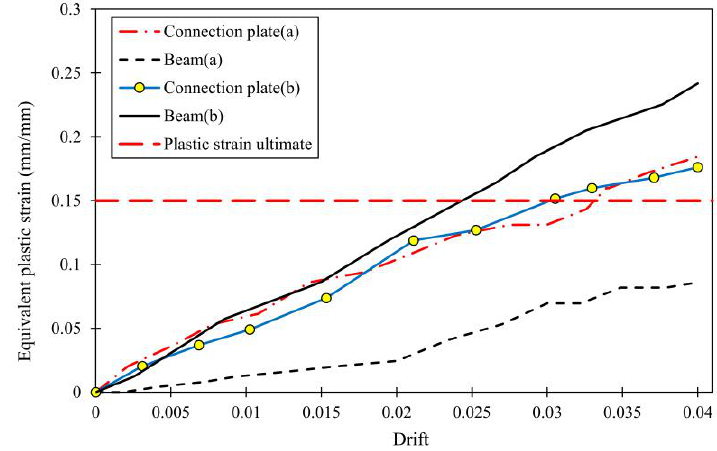
Figure 15. Comparison of equivalent plastic strain.